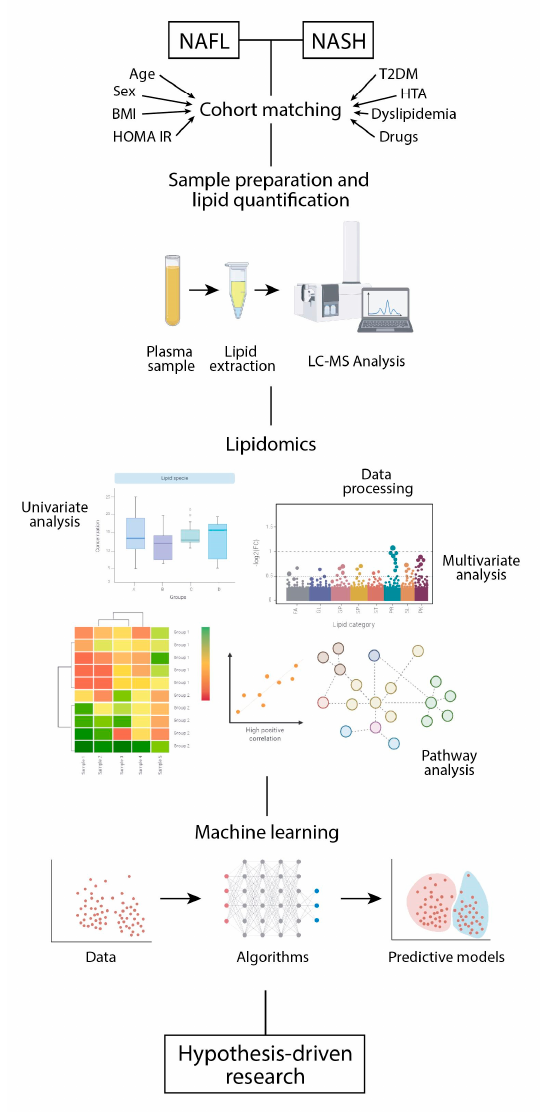
Figure 3. Lipidomics may propel the noninvasive assessment of progressive liver disease. Schematics illustrating important factors in the design of case-control studies aimed to understand the pathogen- esis of nonalcoholic steatohepatitis (NASH). As part of the metabolic syndrome, cohort matching is an essential task that considers potential covariates. The management of samples and analytical pro- cedures are crucial to provide high quality data. Lipidomics analysis results in an enormous amount of data that require the use of computers in each step of analysis and machine learning methods may ultimately result in predictive models. Created with BioRender.com (BioRender, Toronto, ON, Canada) https://biorender.com. Accessed 11 August